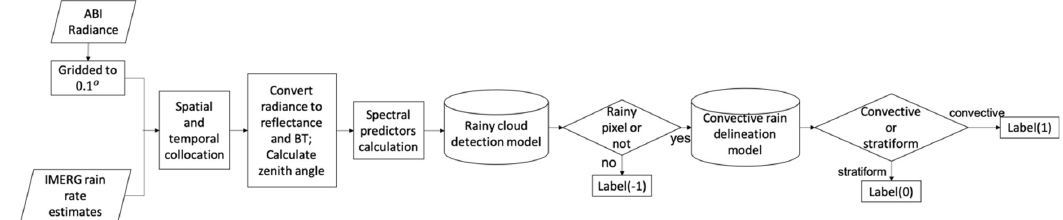
Figure 2. Workflow of the automatic rainy cloud classification system. IMERG is Integrated Multi- Satellite Retrievals for Global Precipitation Measurement; BT is Brightness Temperature. Multi-Satellite Retrievals for Global Precipitation Measurement; BT is Brightness